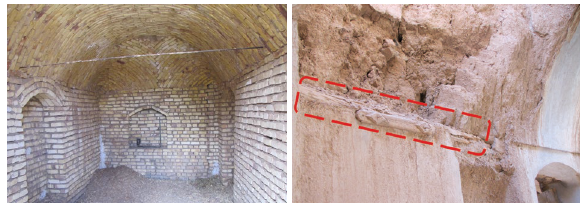
Figure 12. From left; the brick Barrel vault, begin to use wood at the base of the vault, author.